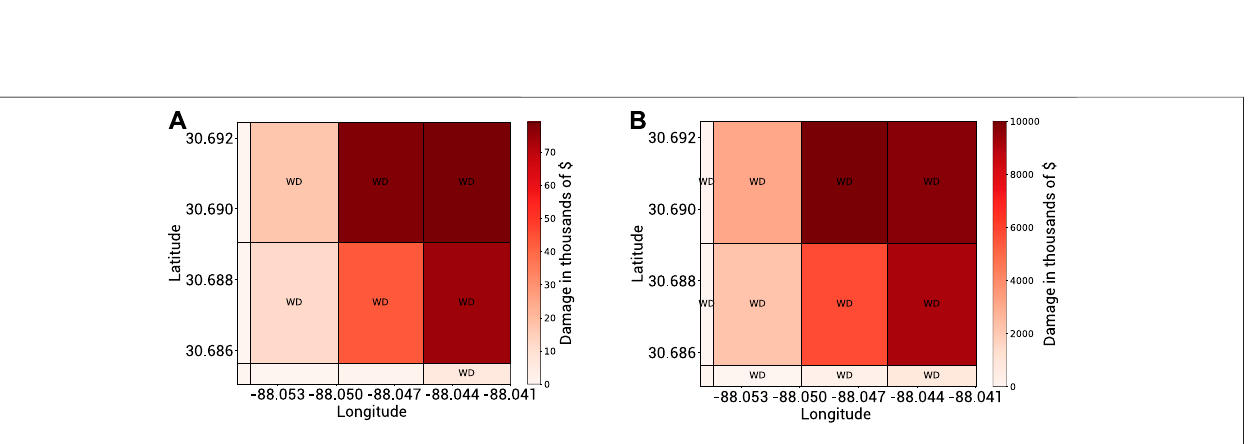
FIGURE 15 | Expected losses for scenarios (A) S KN2005 and (B) S KS2005.